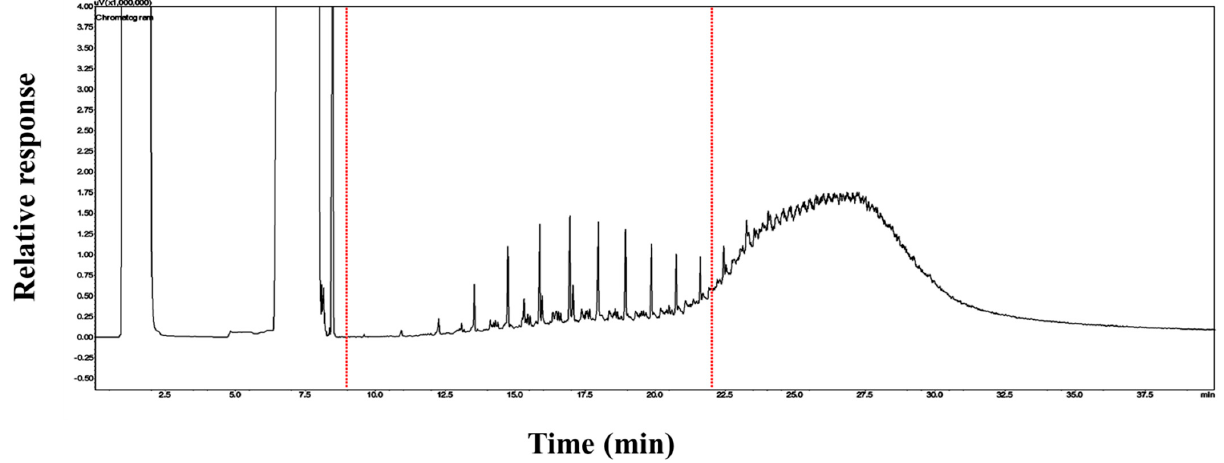
Figure 8. GC chromatogram of the spent lubricant.